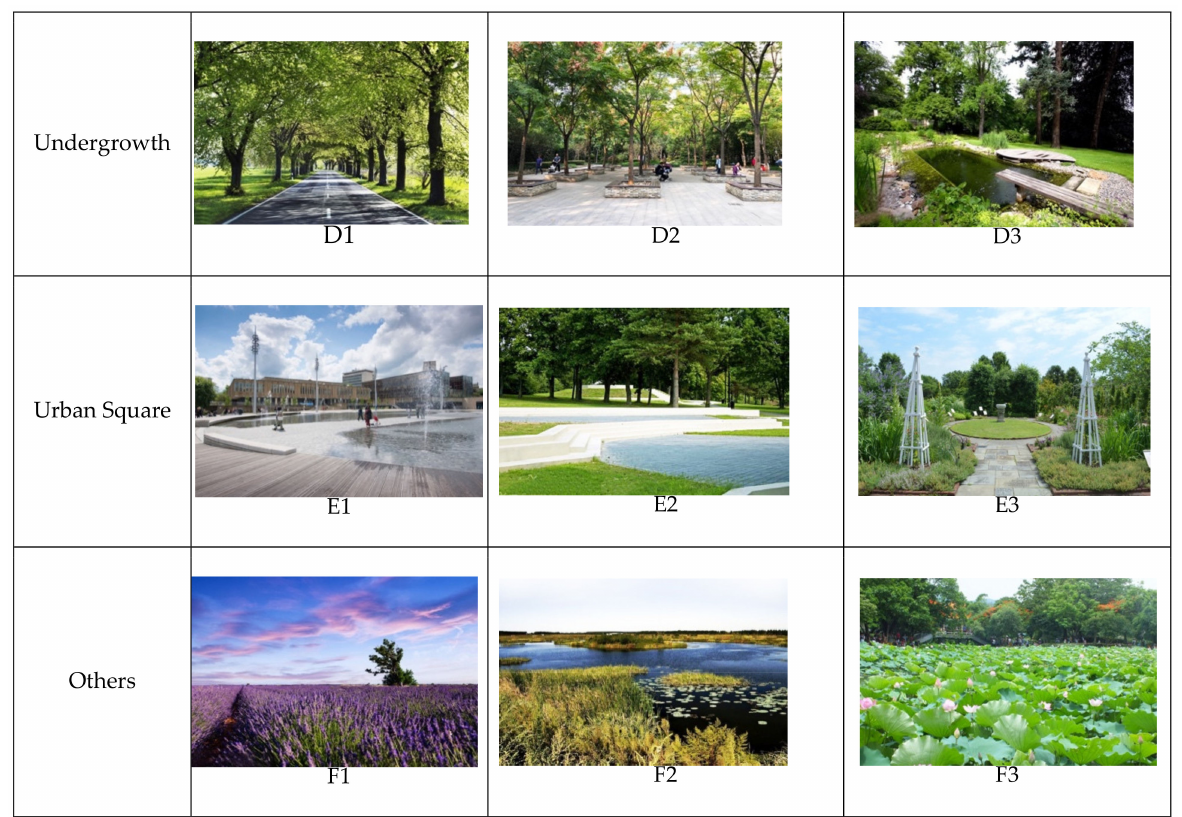
Figure 1. Representative photos for the six landscape